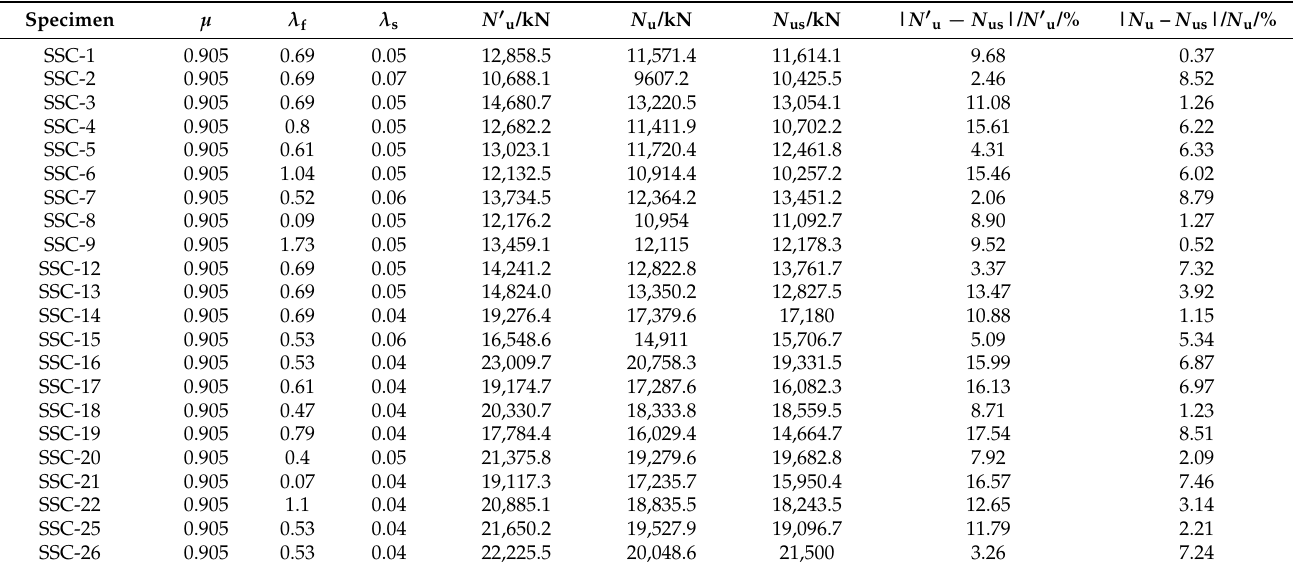
Table 6. Comparison between N (cid:48) u , N u and N us